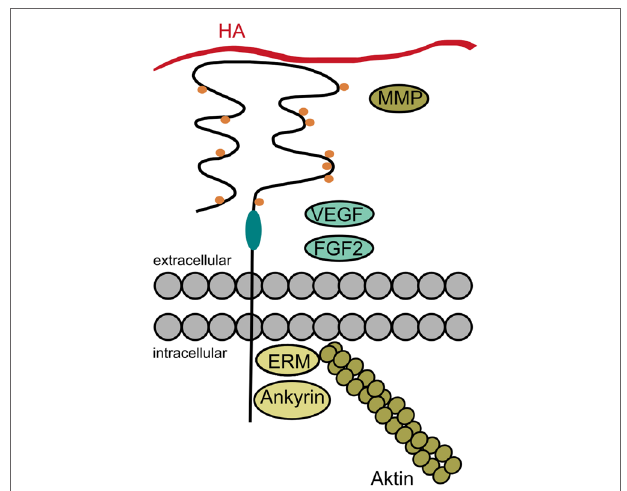
FiGURe 7 | The diversity of CD44. Cellular responses induced by CD44 may be regulated on several levels: the alternative splicing in the stem region of CD44 (indicated in turquoise) may give rise to additional posttranslational modifications and binding sites. The posttranslational modifications (indicated as orange dots) may regulate the receptor’s binding affinity and localization. Besides its principal ligand hyaluronan (HA), CD44 and especially its variant isoforms may also bind other ligands, such as fibroblast growth factor 2 (FGF2), vascular endothelial growth factor (VEGF), and matrix metalloproteinases (MMPs). Intracellularly, CD44 bears binding sites for ankyrin and the ezrin, radixin, moesin (ERM) proteins in order to interact with the cytoskeleton. But CD44 may also associate with a variety of receptors and signaling molecules as a co-receptor or via its cytoplasmic domain (data not shown in the